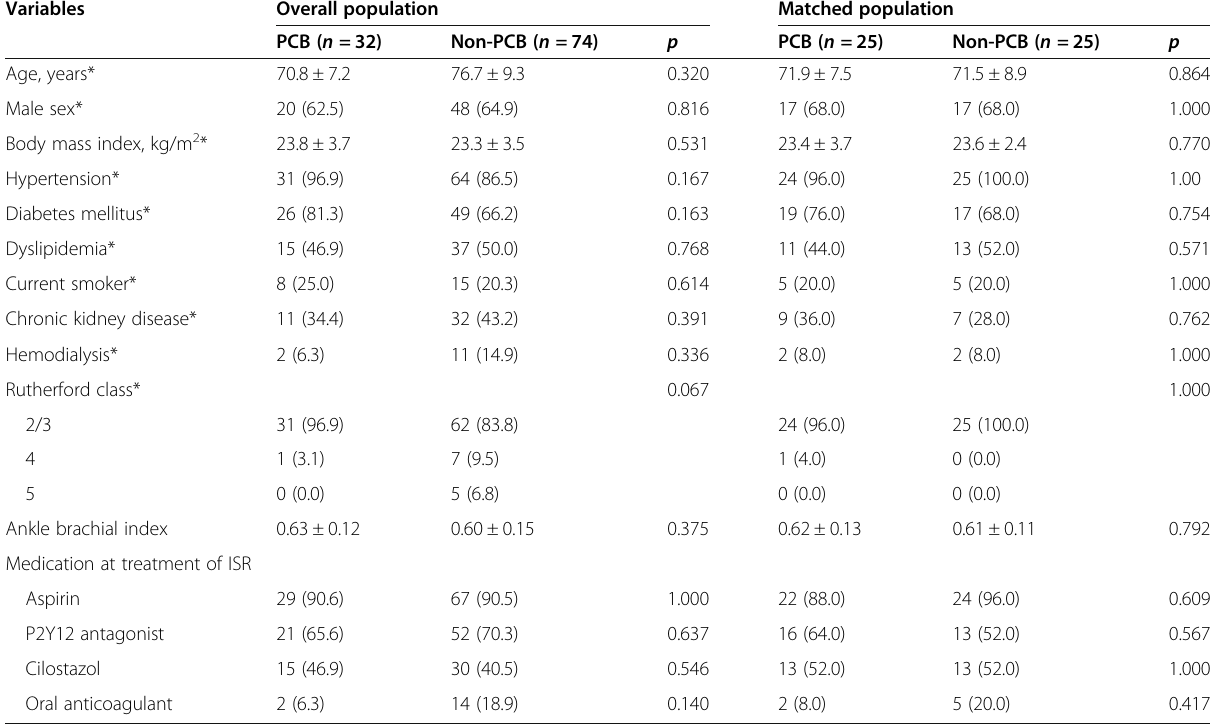
Table 1 Baseline Clinical